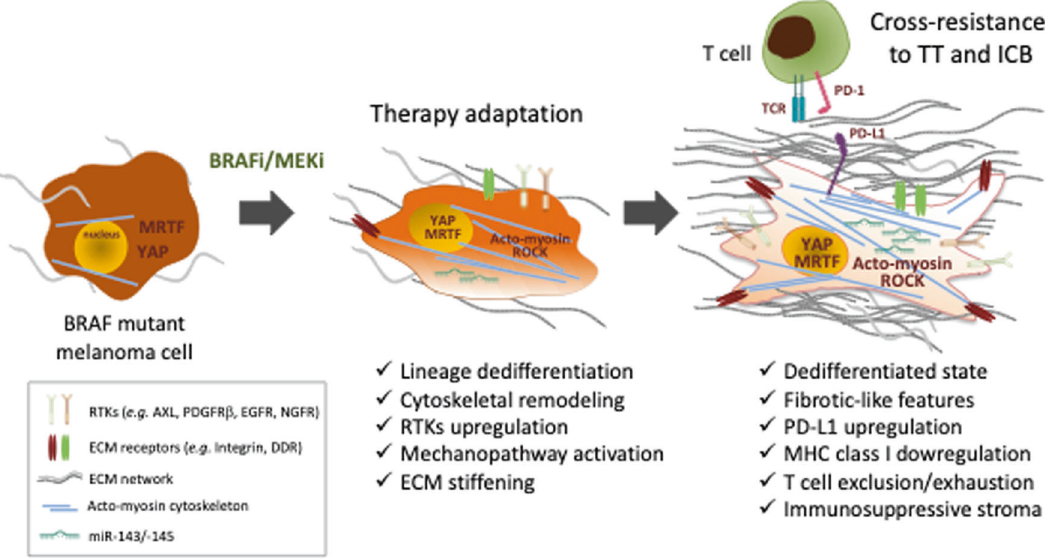
Fig. 1 Mechanical phenotypic plasticity in melanoma therapy resistance. Upon treatment with the BRAFi/MEKi combination of targeted therapies (TT), and after an initial response phase, BRAF mutant melanoma cells undergo a series of phenotypic changes during a phase of therapy adaptation, which eventually leads to the acquisition of characteristics favoring cross-resistance to TT and immune checkpoint blockade (ICB) (e.g. anti-PD-1). RTKs receptor tyrosine kinases, ECM extracellular matrix, MHC major histocompatibility complex, TCR T cell antigen